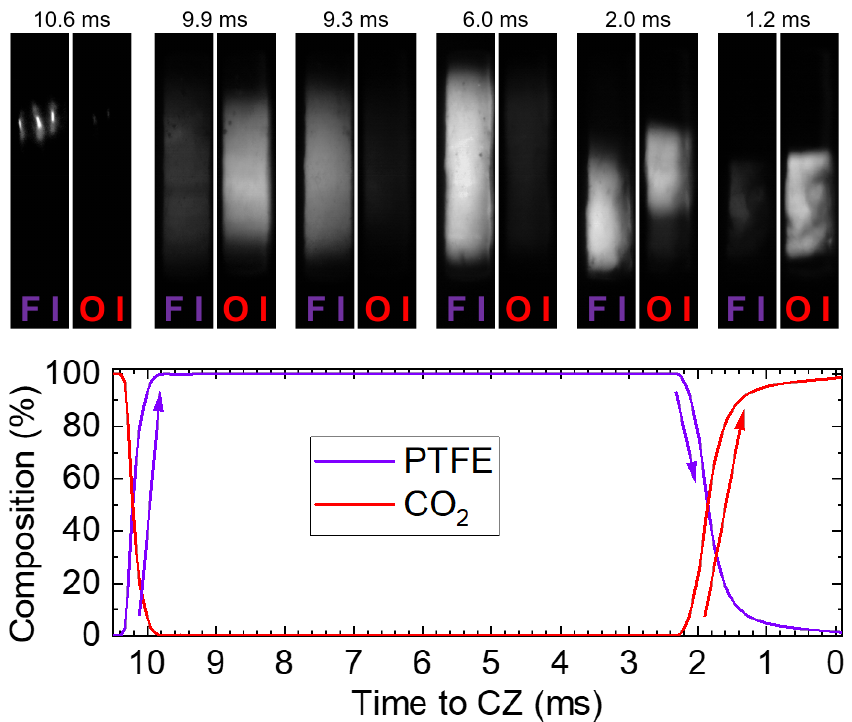
Figure 4. Visualization of the flow reversal before CZ for setup (b). Top : Selected frames of high-speed cameras (HSC) imaging using double frame optics; filters were applied for the atomic line emissions of F I 675nm (left channel) and of O I 777nm (right channel) to visualize emission from PTFE and CO 2 , respectively. Bottom : Plasma composition as obtained from the CFD